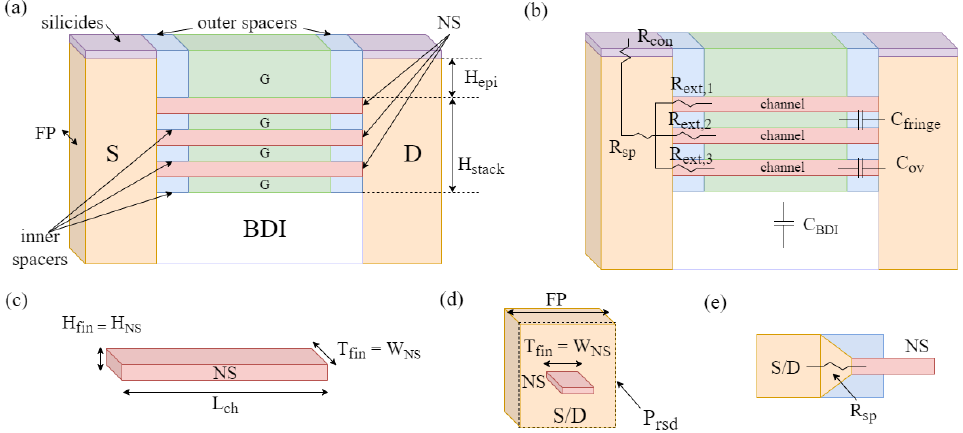
Figure 1. ( a ) NS-GAAFET structure—in green, we show the gate stack. ( b ) Sketch of the parasitic resistance and capacitance contributions. ( c ) NS geometrical parameters and dimensions. ( d ) Fin Pitch (FP) definition. ( e ) Spread resistance R sp geometrical